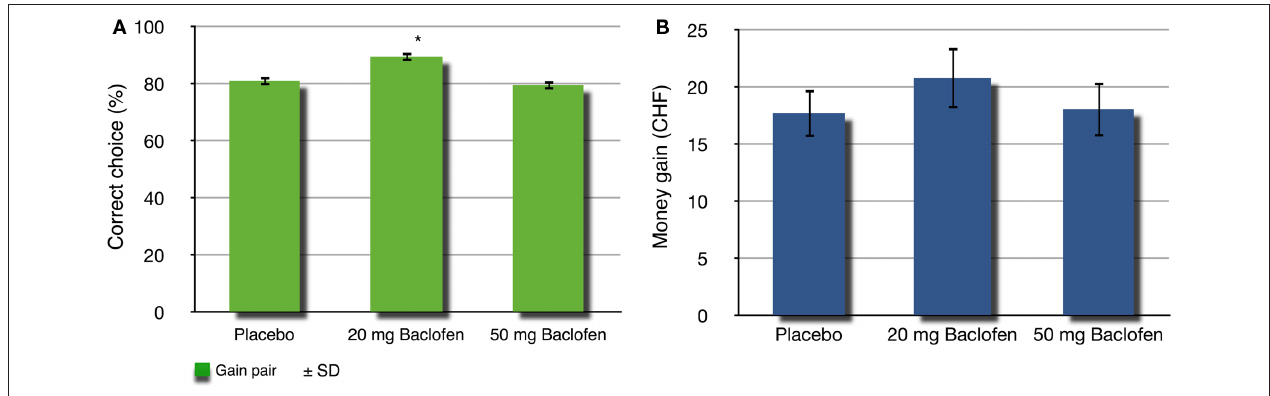
Figure 2 | Correct choice and money earned. (A) Percentage of correct choice after three concomitant sessions of 20 trials for the gain condition. There is a statistical difference between the 20-mg baclofen and the control group (* p < 0.01). (B) Amount of money earned after three concomitant sessions of 20 trials for each, the gain, loss, and neutral condition for the control, 20 mg baclofen and 50 mg baclofen groups. ± SD means standard